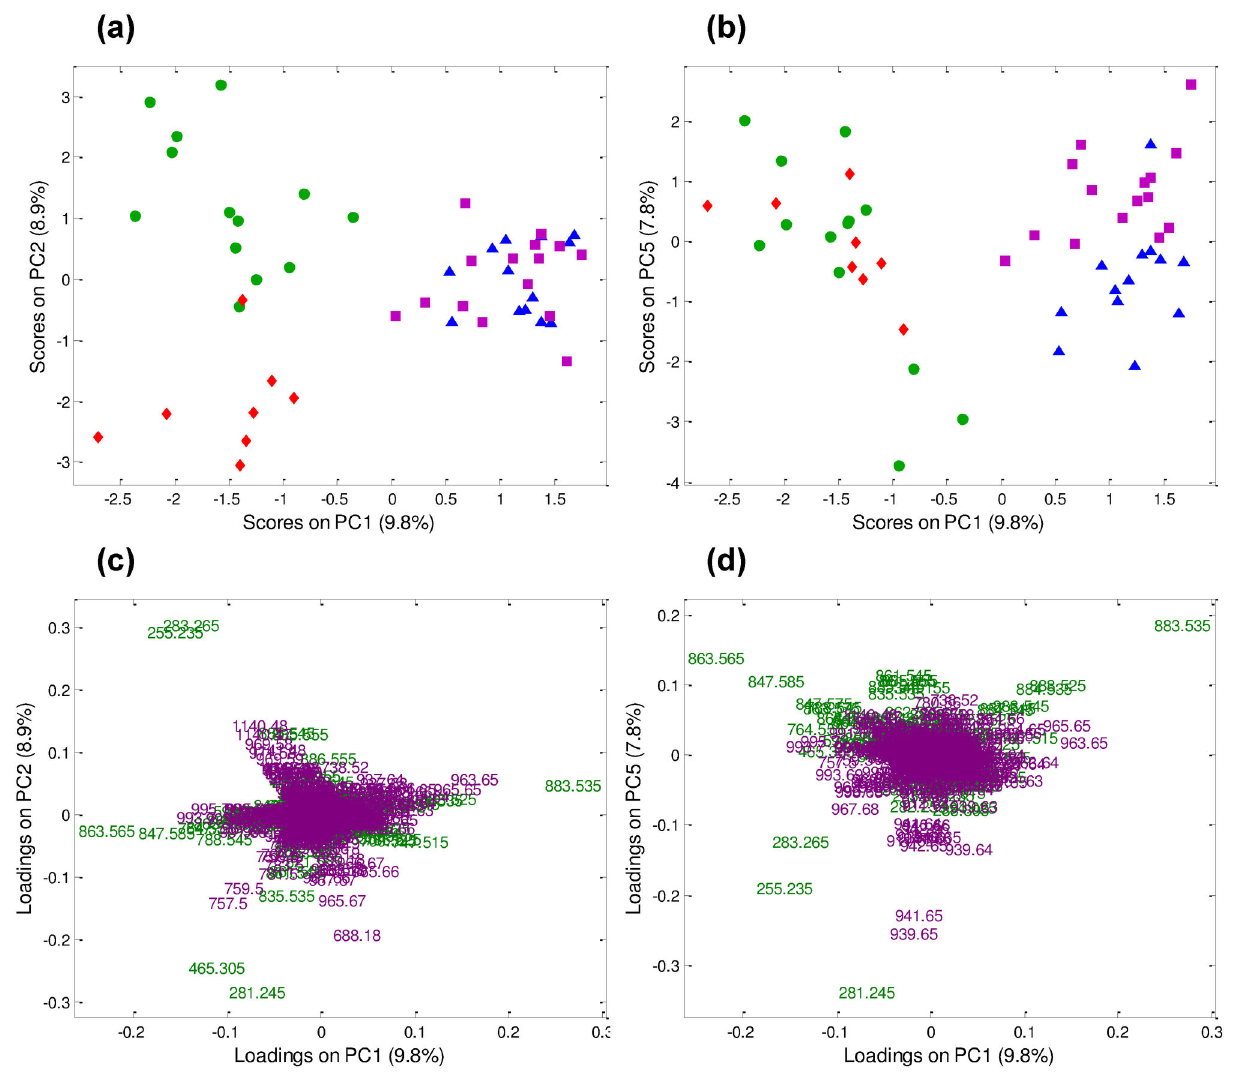
Figure 2. PCA of the fused datasets from positive and negative ion mode mass spectra. ( a ) PC1 vs. PC2 score plot. ( b ) PC1 vs. PC5 score plot. ( c - d ) PC1 vs. PC2 (left side) and PC1 vs. PC5 (right side) original loading plots labeled in terms of m/z ratio (green: original negative ion mode dataset; violet: original positive ion mode dataset). Blastocysts produced in vitro (green circles, n= 13), blastocysts produced in vivo (red diamonds, n= 8), immature oocytes (blue triangles, n= 13) and in vitro matured oocytes (violet squares, n=